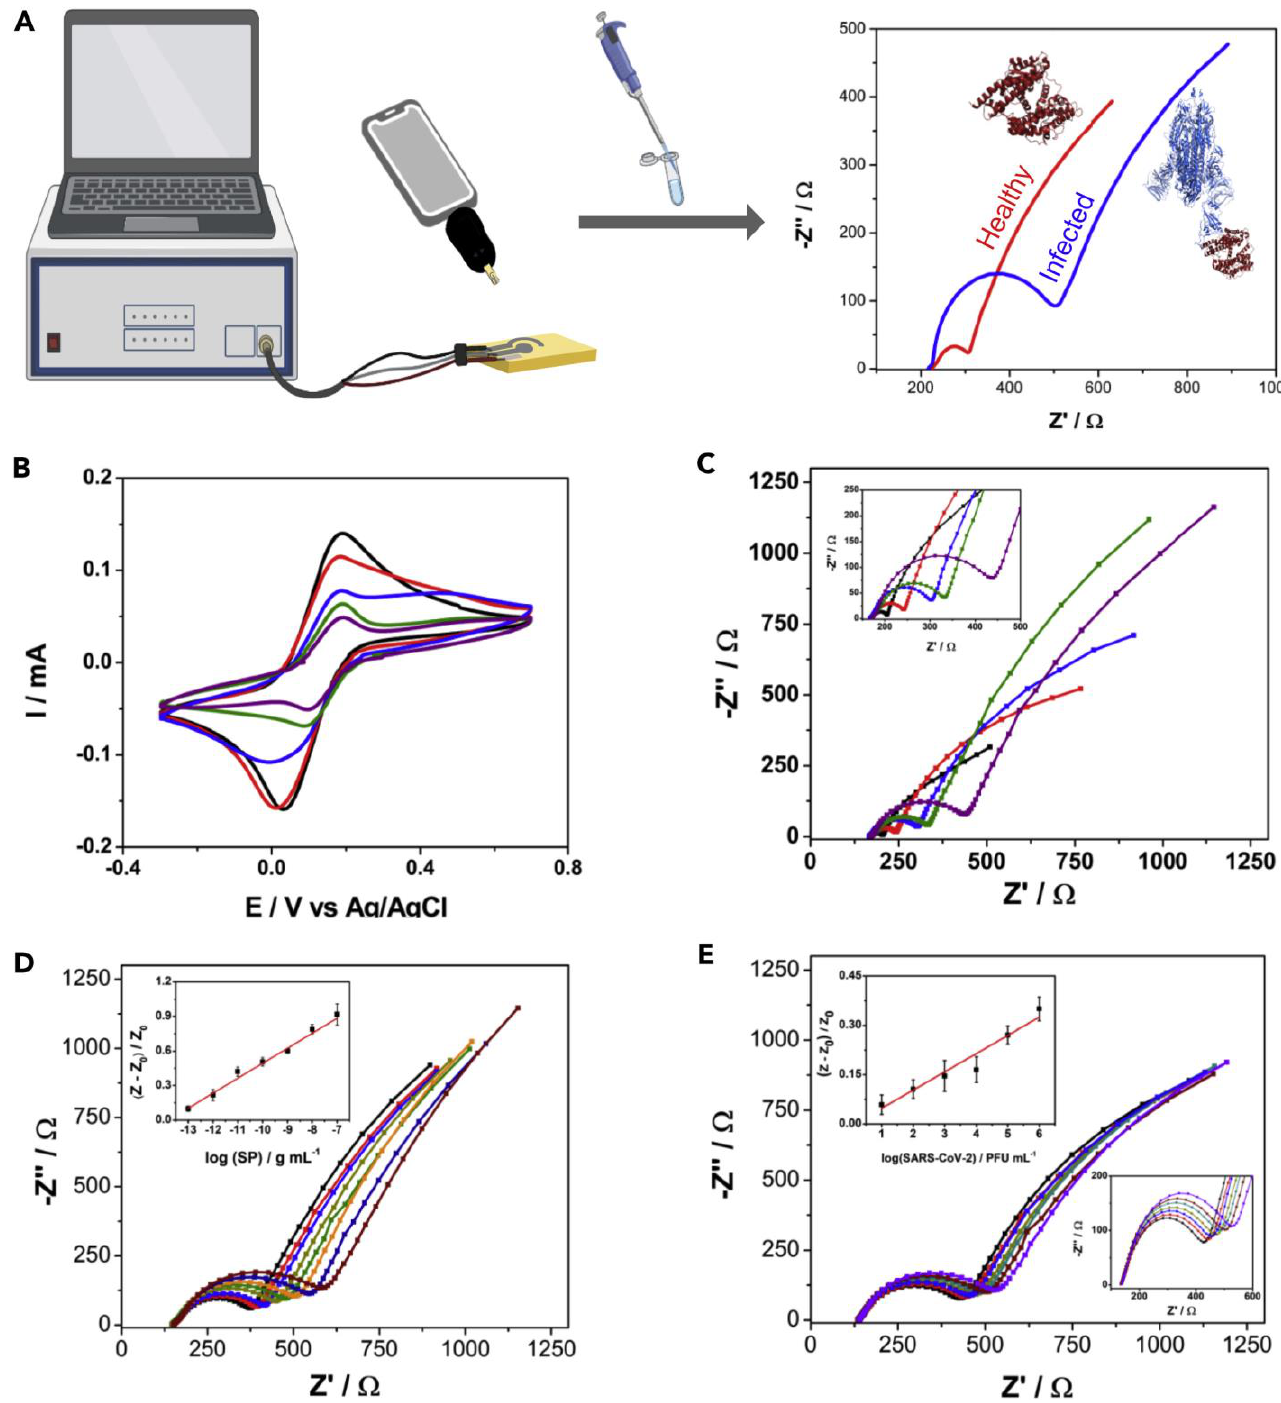
Figure 6. Characterization of the functionalized electrode and development of calibration curve. ( A ), Workflow of the method. ( B ), Cyclic voltammetry (CV) plots of different functionalization steps showing change in current with addition of functionalization layers. ( C ), Nyquist plots of different functionalization steps showing change in charge transfer resistance (R CT ) with each functionalization step. ( D ), Nyquist plots for varying concentration of spike protein in saliva of a healthy donor. While E shows sensor response to varying concentrations of inactivated virus. Insets in D and ( E ) show linear range of the system. Responses after functionalization with glutaraldehyde, ACE2, BSA, and Nafion are shown in red, blue, green, and purple, respectively, while response of bare electrode is shown in black. Reprinted from Ref. [51] with permission from Elsevier. © 2021 Elsevier Inc.